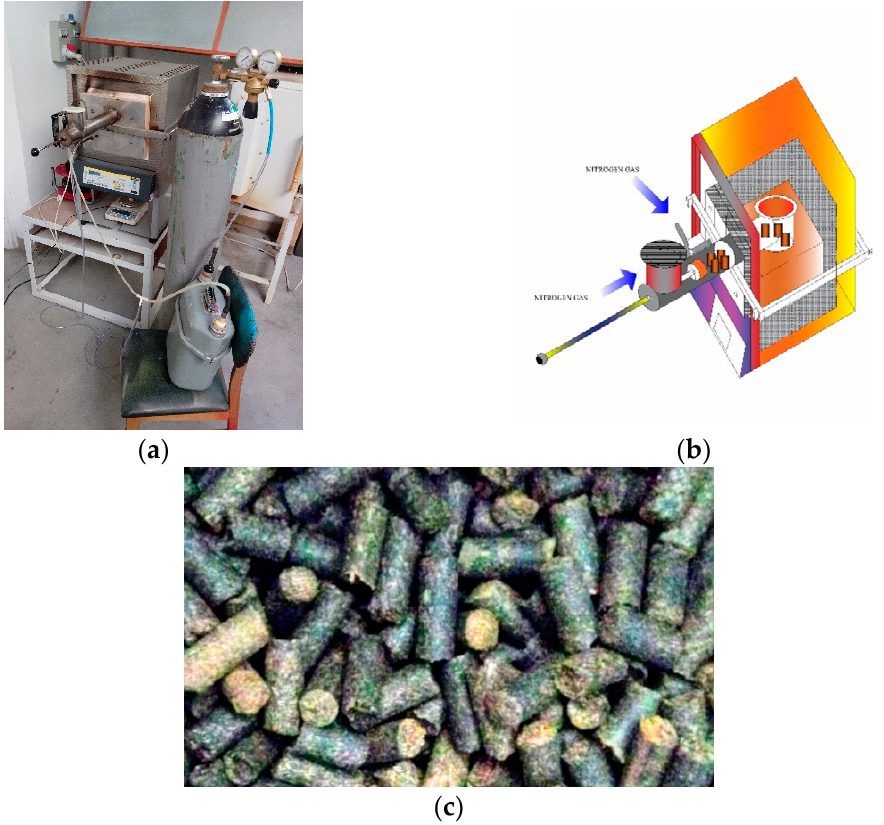
Figure 1. The modified furnace used for thermal pre-treatment: ( a )—Unit, ( b )—Sketch, ( c )—Torrefied pellets.